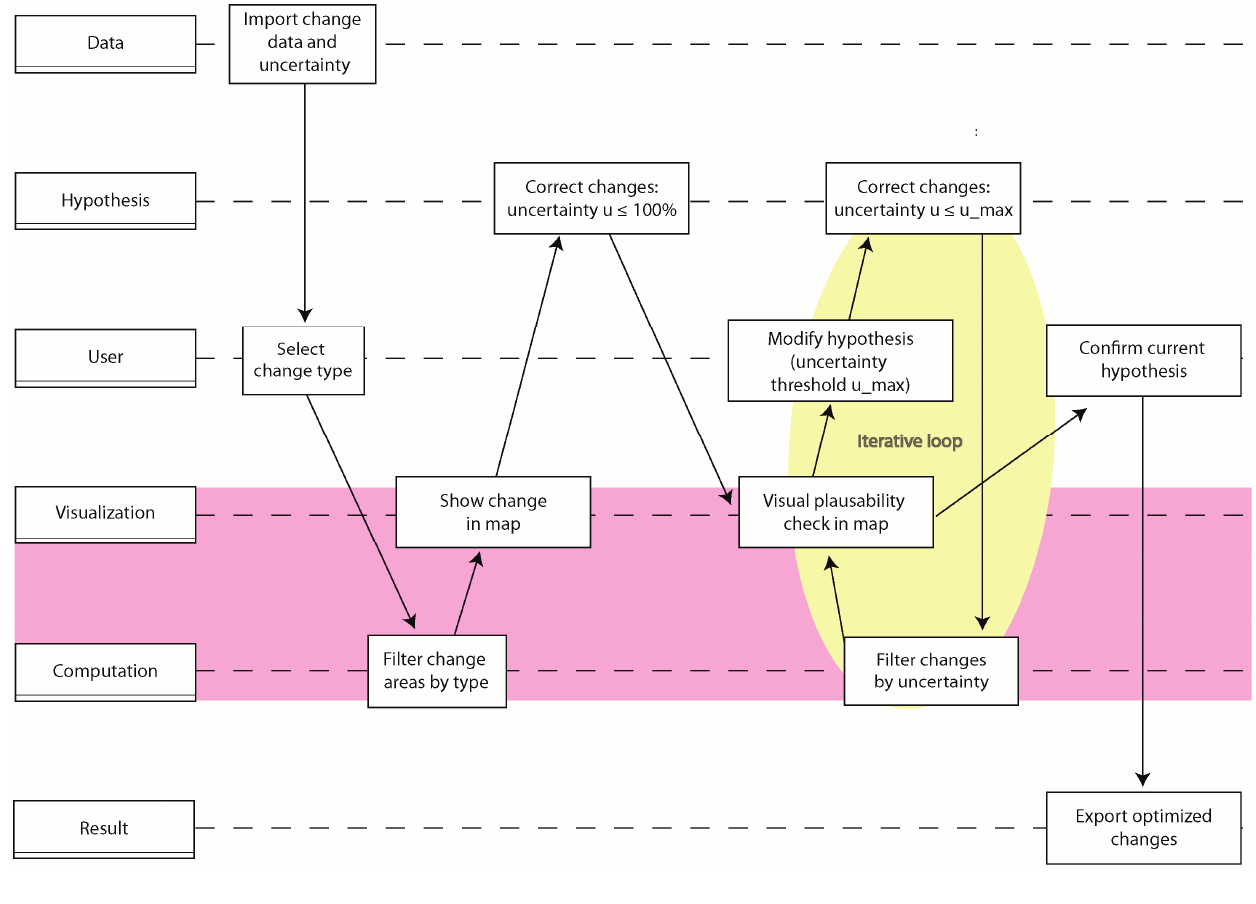
Figure 5. Workflow: Filtering change by uncertainty to reduce false-positive